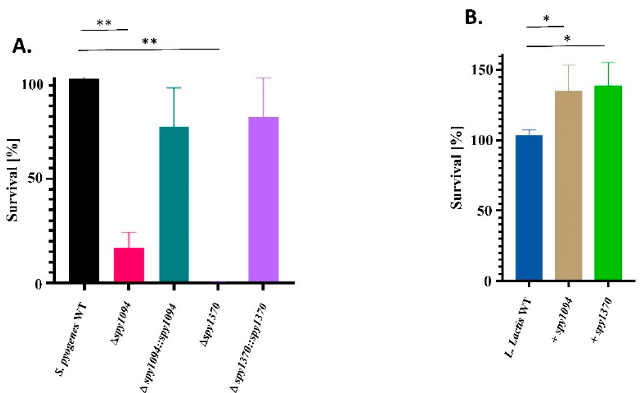
Figure 3. Spy1094 and Spy1370 contribute to lysozyme resistance. Wildtype and mutant strains were treated with 80 μ g/mL lysozyme and incubated for 30 min at 37 °C. Surviving bacteria were enumerated by spot plating in triplicates on agar plates. ( A ) S. pyogenes strains. ( B ) L. lactis strains. Data are mean values from four independent experiments in triplicates +/ − SD. P values were calculated using the one ‐ way ANOVA tests. ** p < 0.001; * p < 0.05.